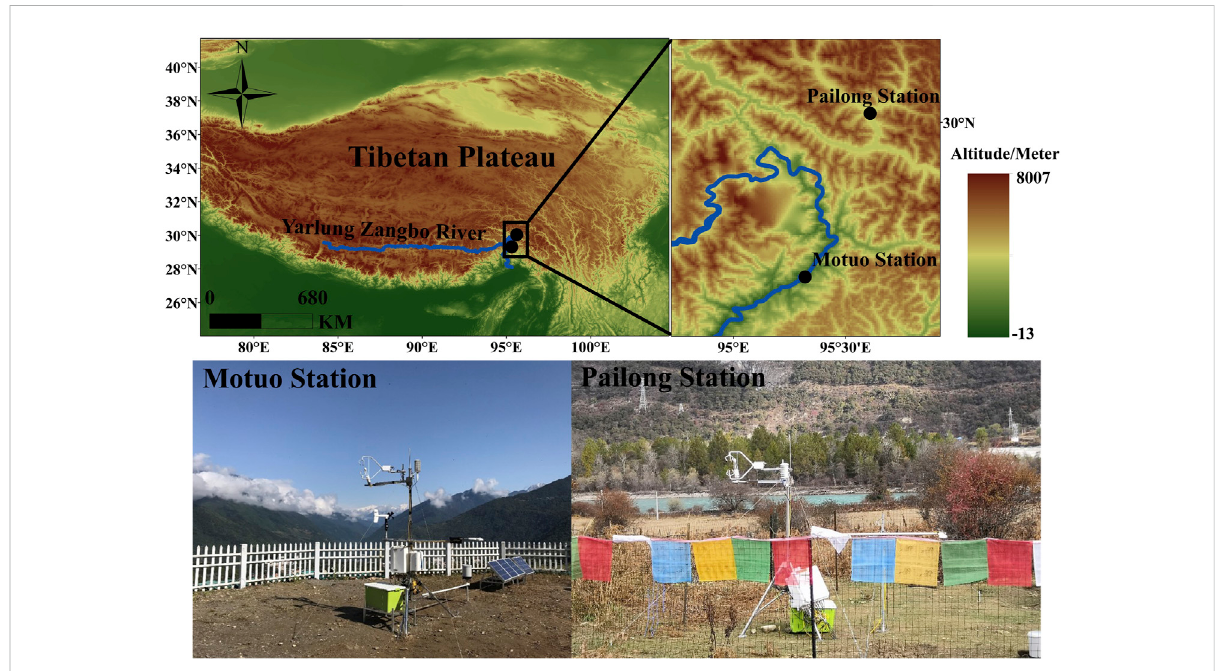
FIGURE 1 Geographical location and topography (Up) and photos (Low) (Chen et al., 2022) of the Yarlung Zangbo River and location of the in situ observation